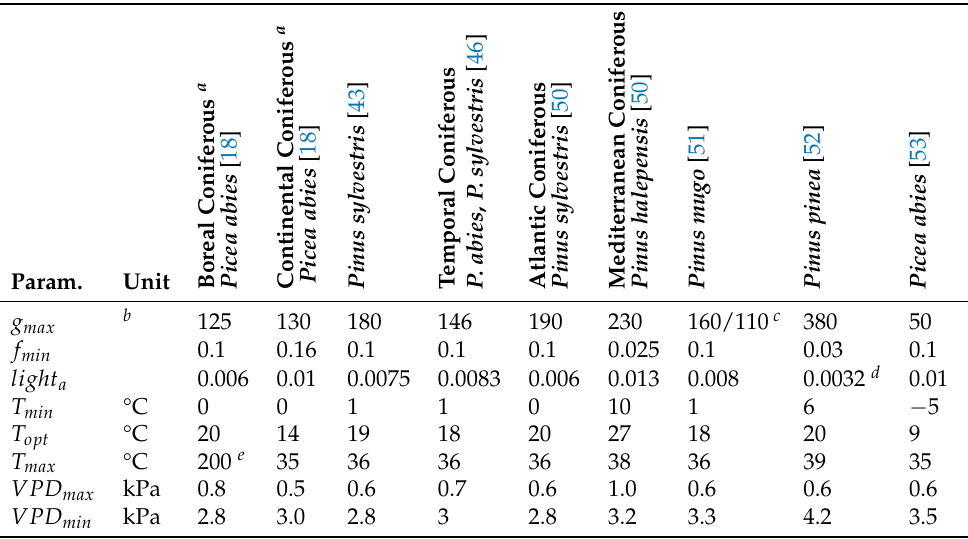
Table 2. Sets of parameterization of the modified Jarvis model for conifer species available in the literature.